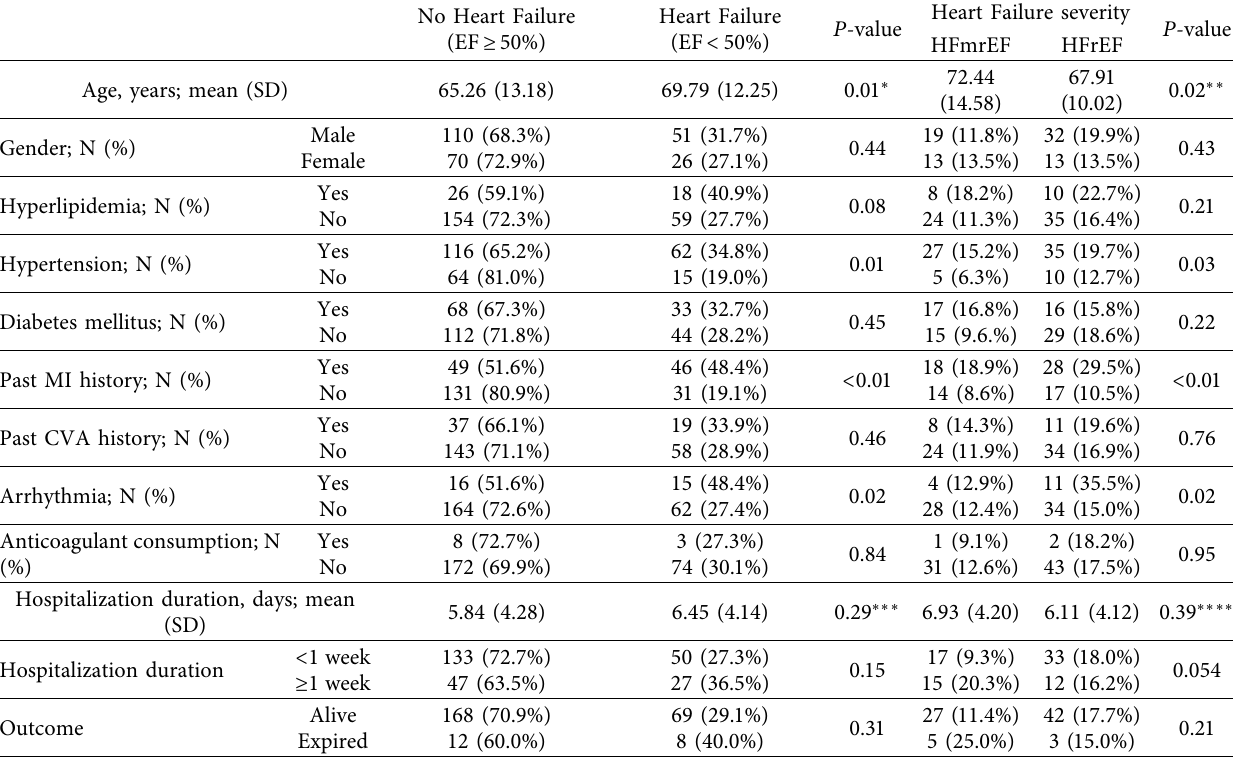
Table 1: Heart failure and its severity association with demographic, and past medical and drug histories of ischemic stroke patients.